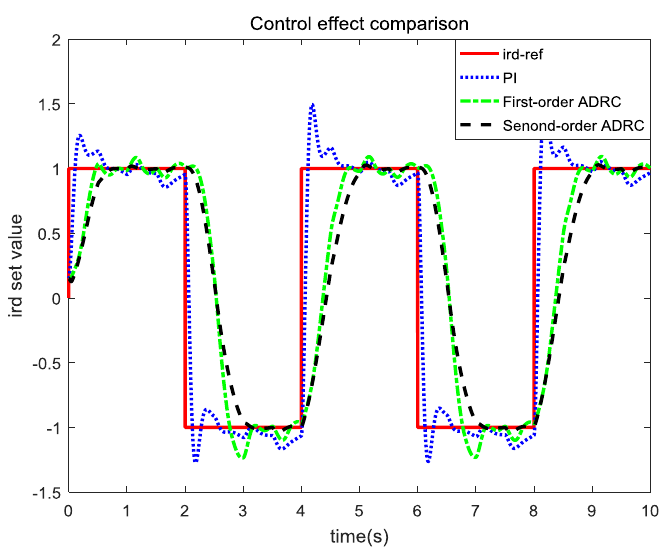
Figure 14. Comparison of control effects under external disturbance.